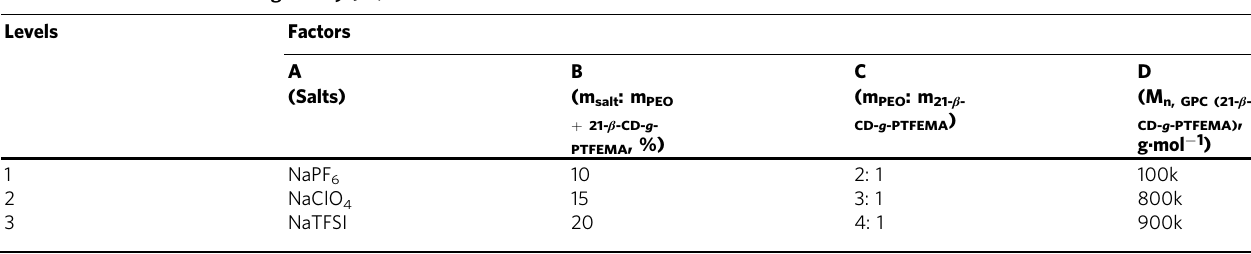
Table 2 The orthogonal experimental design and analysis for sodium metal batteries. Factors and levels of the orthogonal L 9 (3 4 ) test